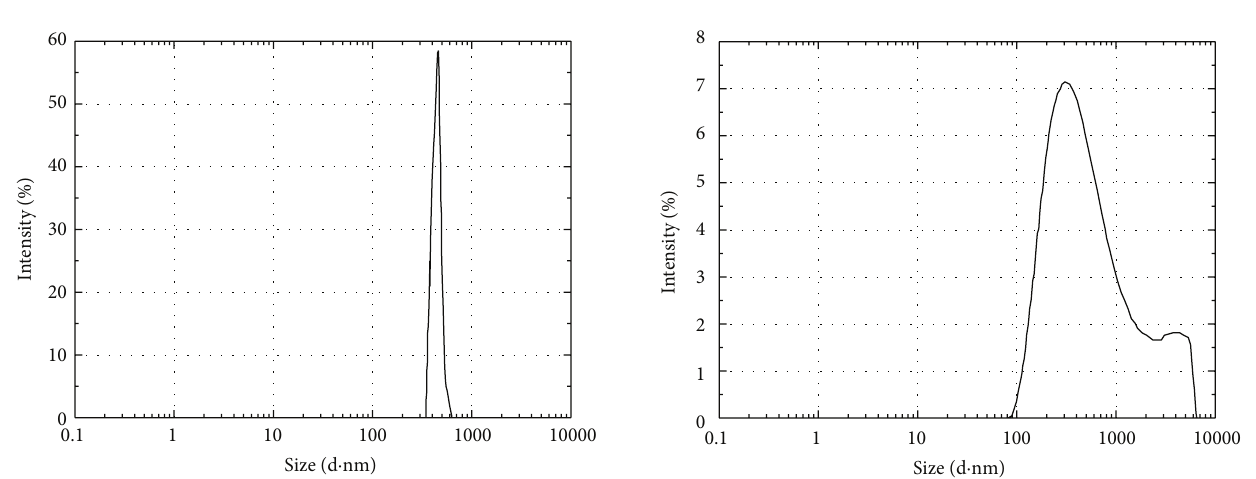
Figure 12: The particle size distribution curve of DPG before high- temperature aging.